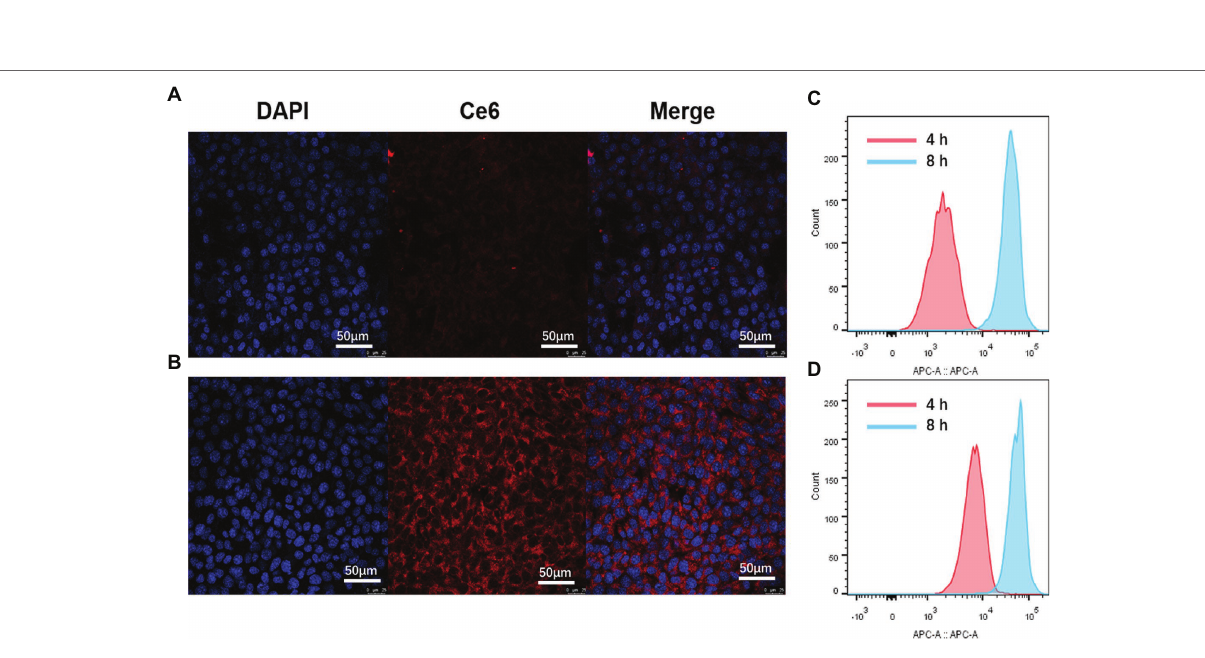
FIGURE 3 | Cellular uptake of HA-sese-Ce6 micelles and free Ce6. CLSM micrographs. (A) cells treated with free Ce6 for 4 h, (B) cells treated with HA-sese-Ce6 micelles FCM profiles, (C) cells treated with free Ce6 for 4 and 8 h, and (D) cells treated with HA-sese-Ce6 micelles for 4 and 8 h.